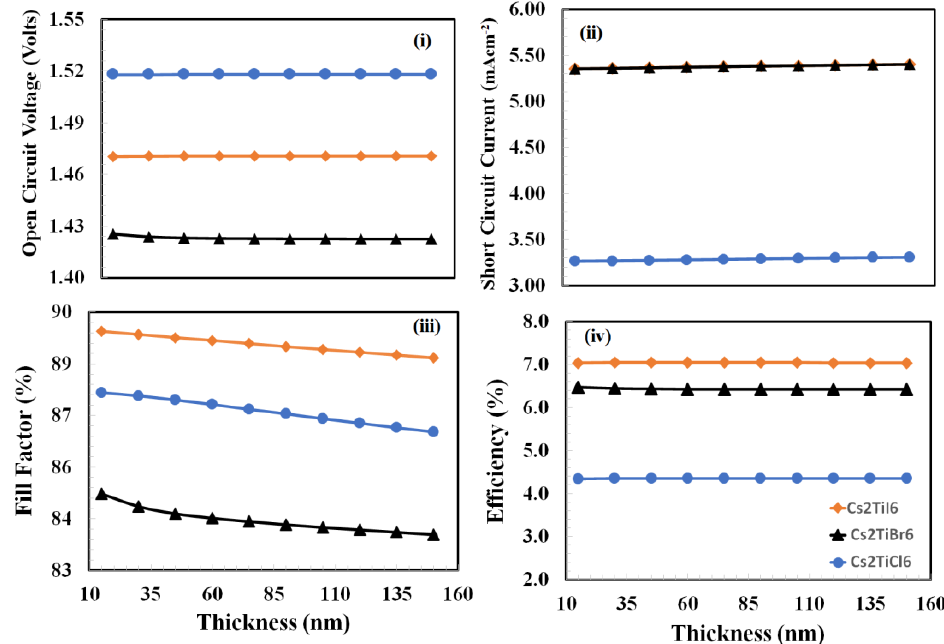
Figure 5. The photovoltaic response parameters: ( i ) open-circuit voltage, ( ii ) short-circuit current, ( iii ) fill-factor, and ( iv ) power-conversion efficiency as a function of the thickness of Nb 2 O 5 (electron- transport layer) for the proposed devices Cs 2 TiCl 6 , Cs 2 TiBr 6 , and Cs 2 TiI 6 respectively.